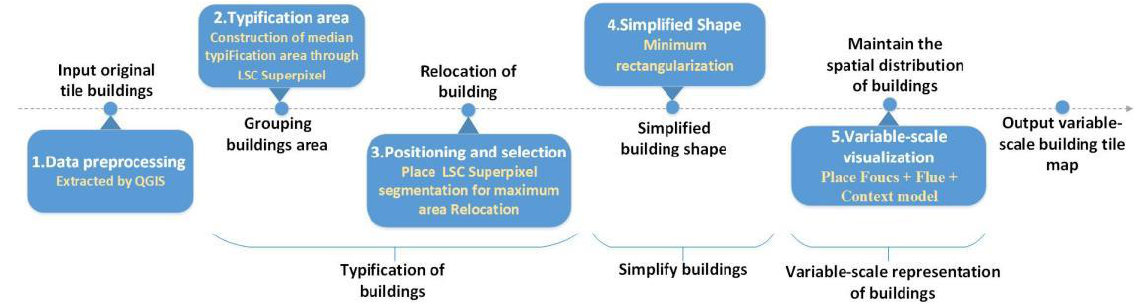
Figure 2. Variable-scale visualization flow chart of the polygonal building area.